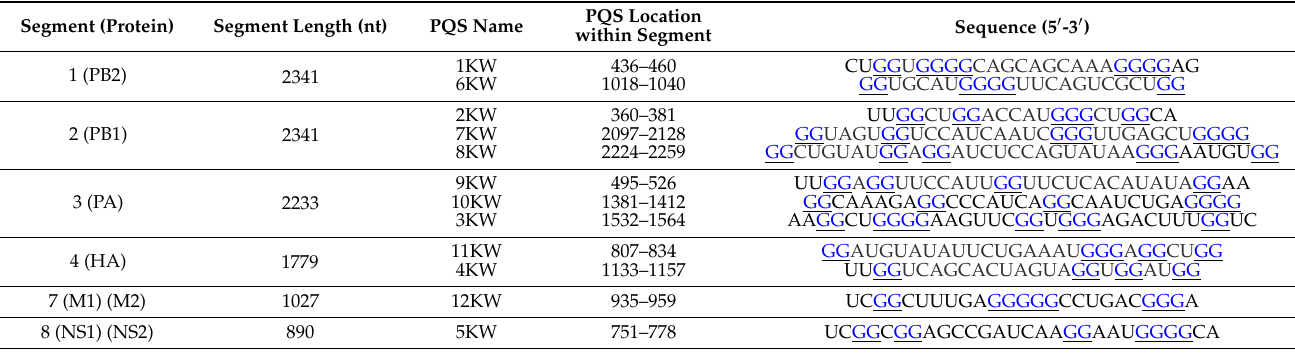
Table 1. Characteristics of potential quadruplex-forming sequences (PQS) motifs from vRNA of the influenza A/California/07/2009(H1N1).